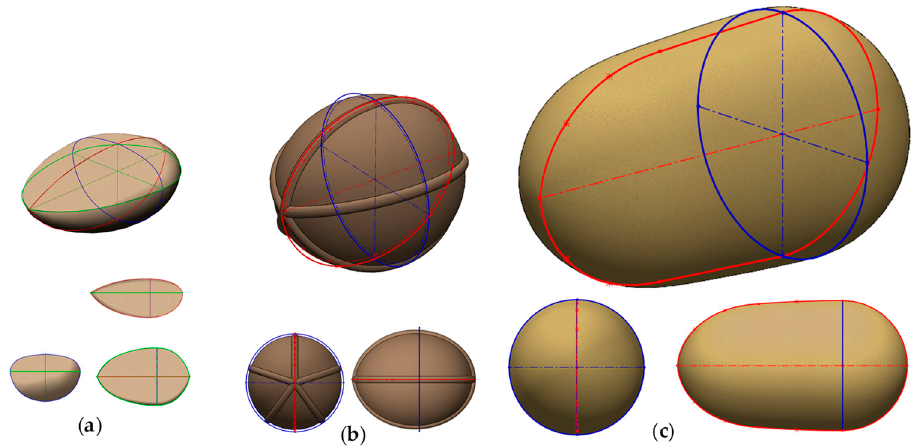
Figure 3. Natural seeds of various size groups: ( a ) Small ellipsoidal Scots pine (Pinus sylvestris); ( b ) Medium spherical European linden (Tilia europaea); ( c ) Large ellipsoidal Pedunculated oak (Quercus robur).